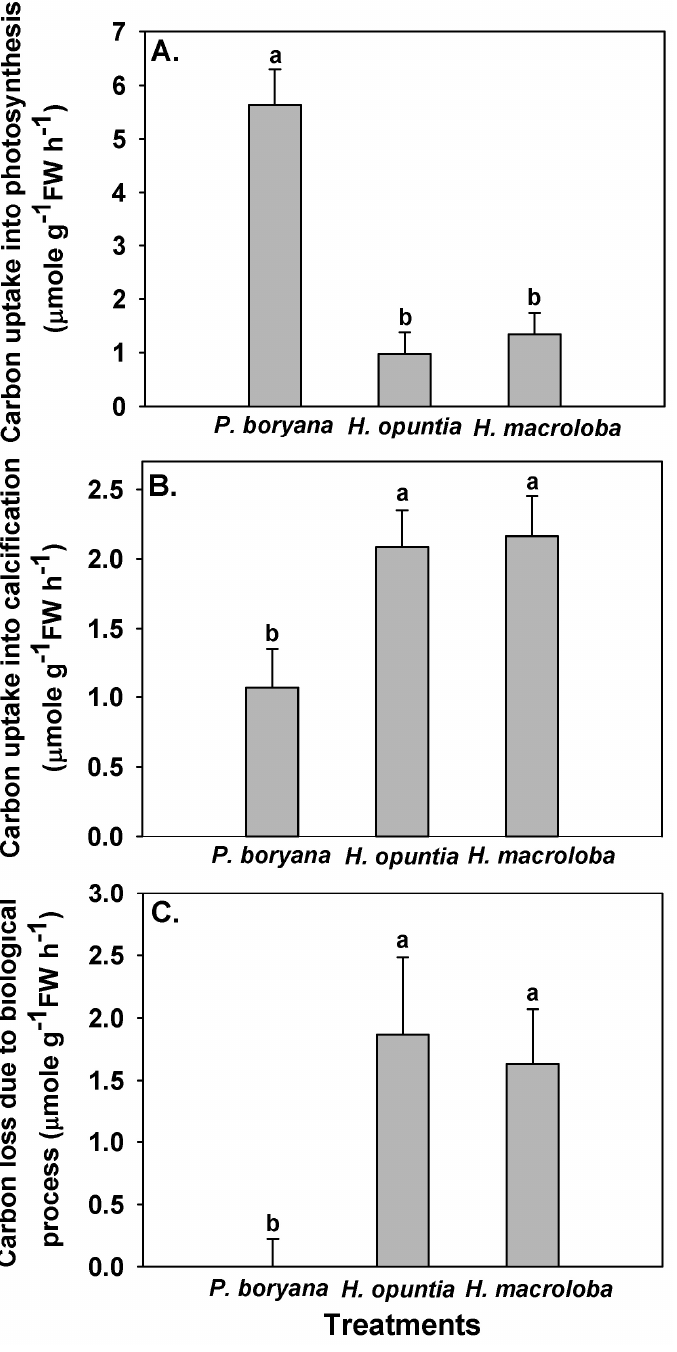
Figure 3. Carbon uptake by photosynthesis ( A ), carbon removal by calcification ( B ) and carbon lost to the air due to incubation ( C ) with Padina boryana , Halimeda opuntia and Halimeda macroloba under an irradiance of 150 µmol photons m − 2 s − 1 . The fates of carbon were calculated according to Kalokora et al. [20]. Different letters above the bar indicate statistical difference (Fisher’s LSD test, p < 0.05). Data are means ± SE (n = 9).